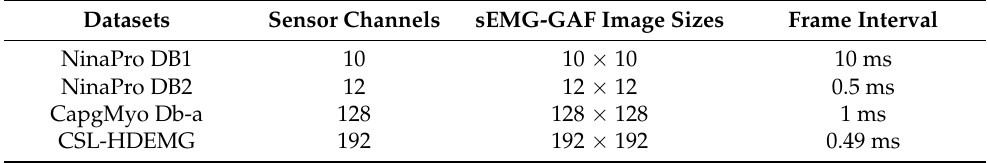
Table 1. Size specification of the converted sEMG-GAF image for each